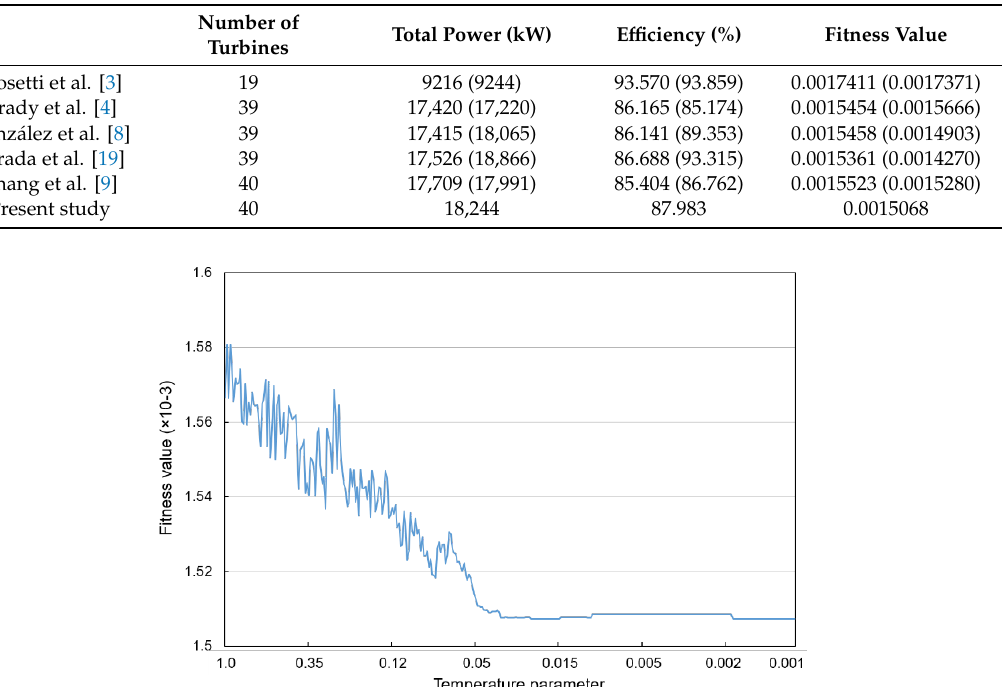
Figure 8. Fitness variation during the process in case study (b). Table 4. Layout Results for Case Study (b).